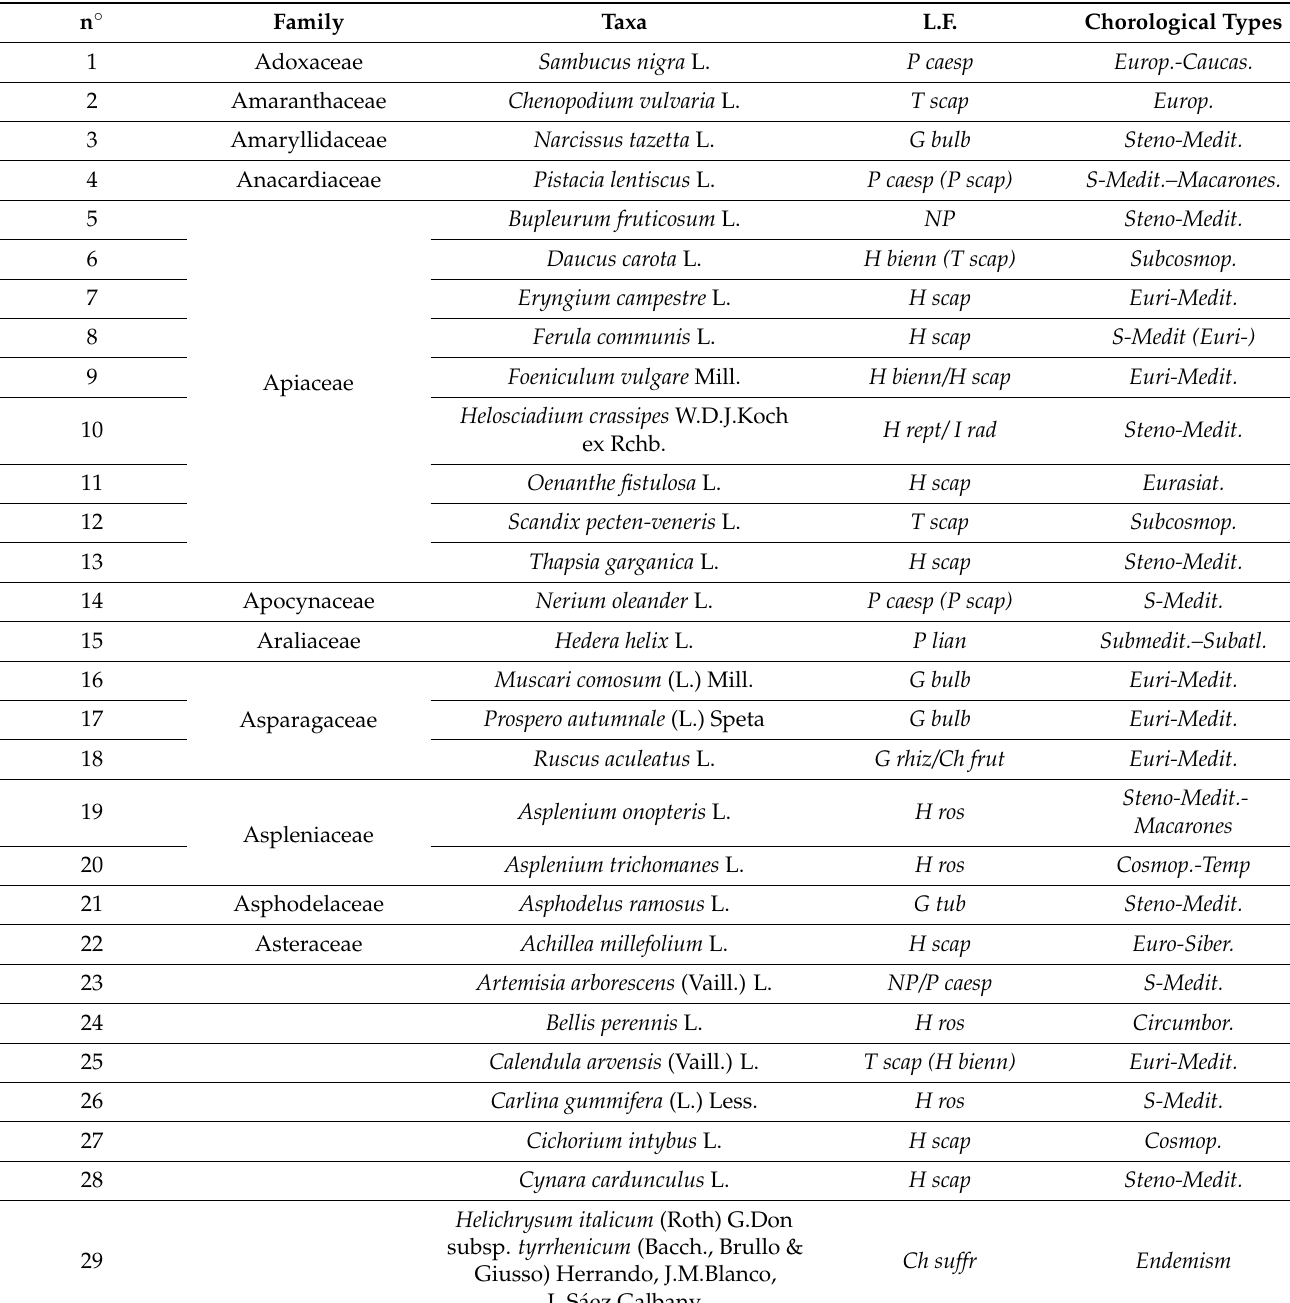
Table 2. Life Forms and Chorological